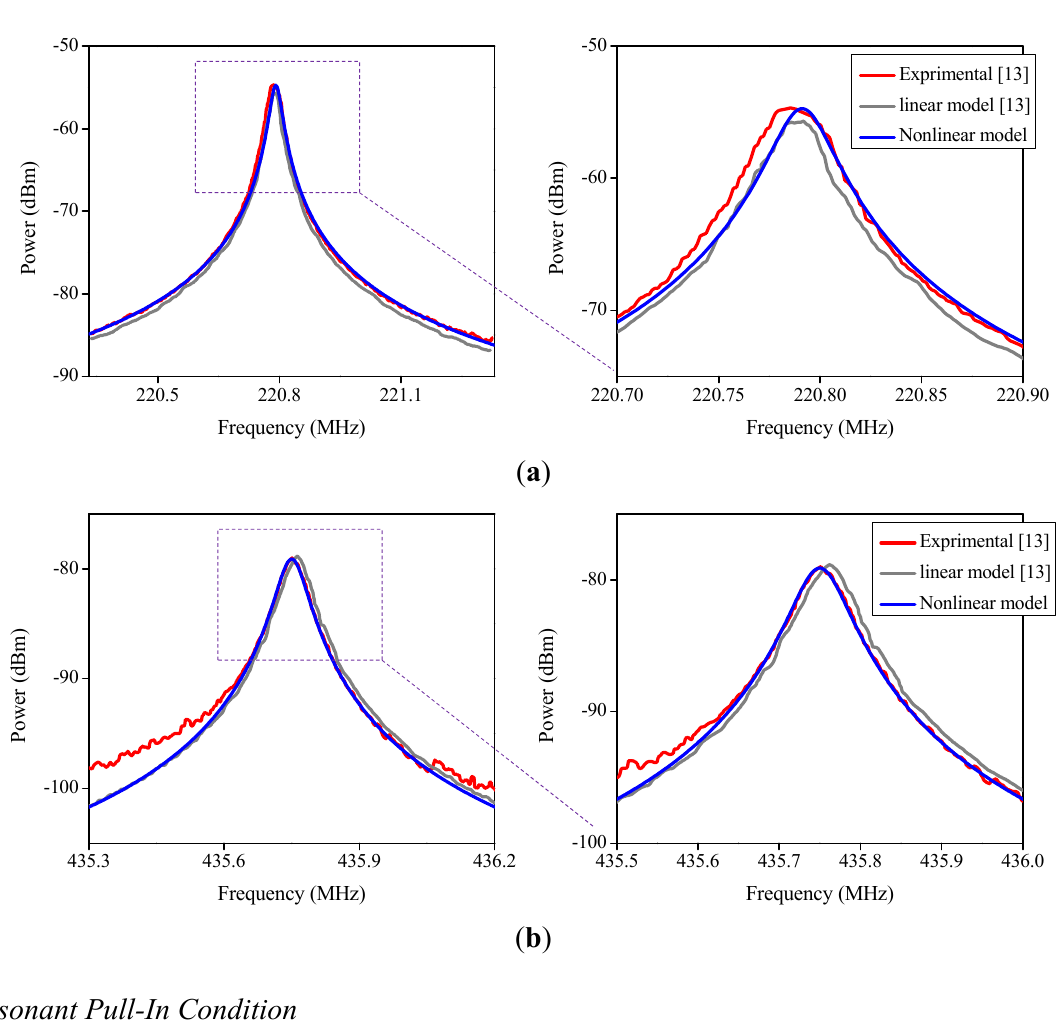
Figure 5. The frequency response for polysilicon extensional wine-glass (EWG)